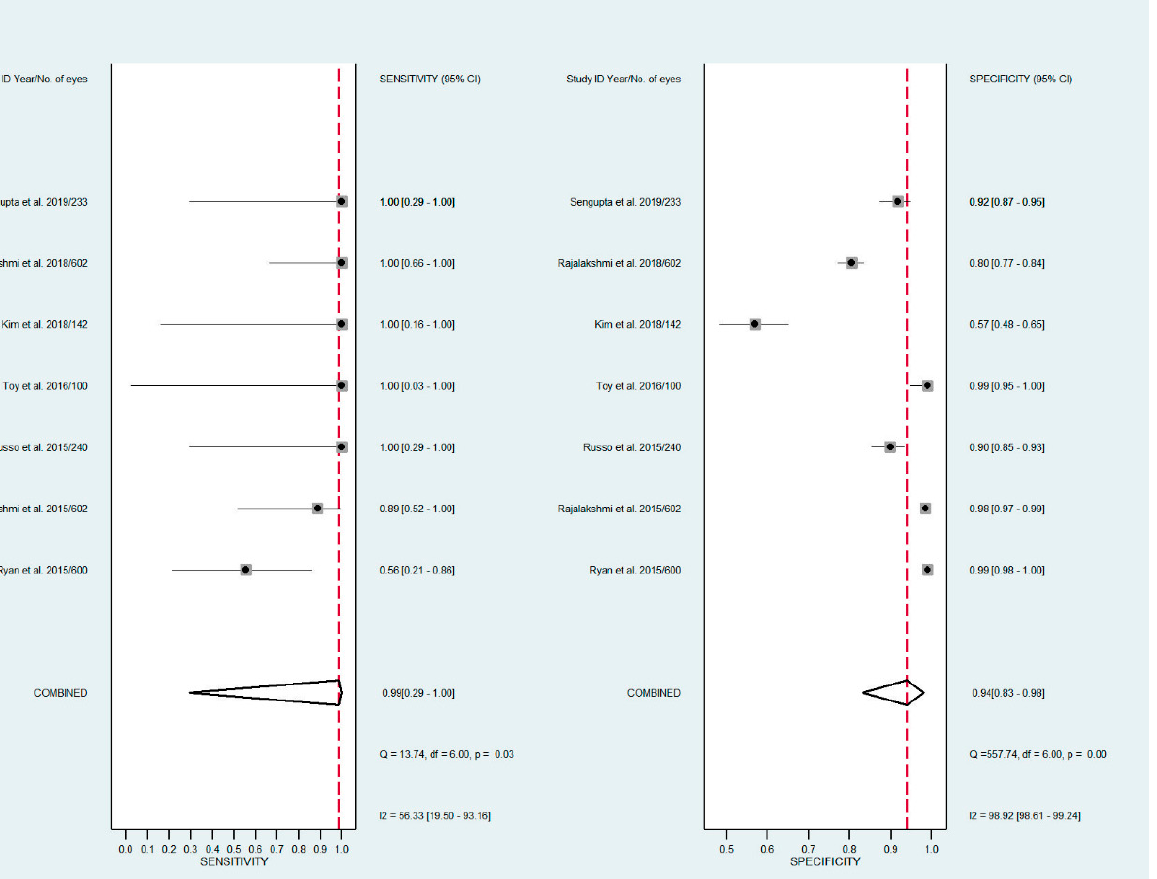
Figure 4. Forest plots for the sensitivity and specificity of non-mydriatic fundus photography.